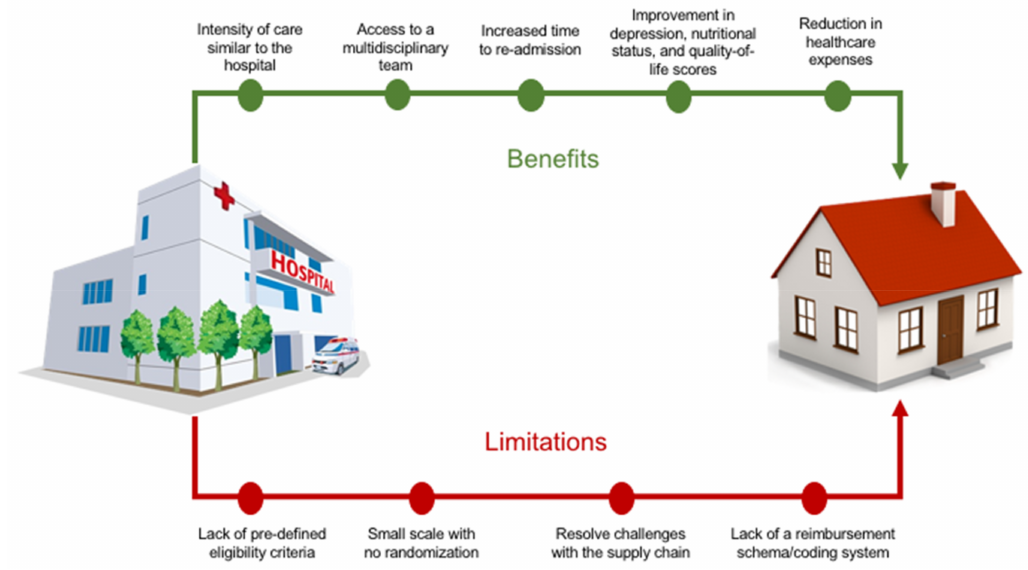
Figure 1. Central Illustration: Benefits and limitations of home hospitalization